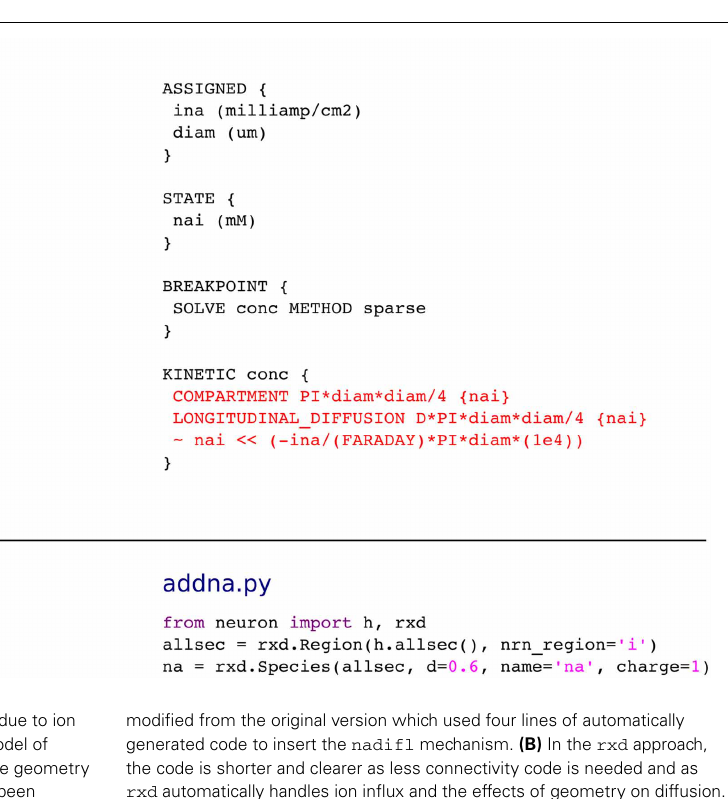
the code in (A) with the CVode method using NEURON’s standard Run Control panel. The plot with labels was generated with NEURON’s Shape Plot GUI tool. The 600ms simulation ran in 1.06s on our test machine.